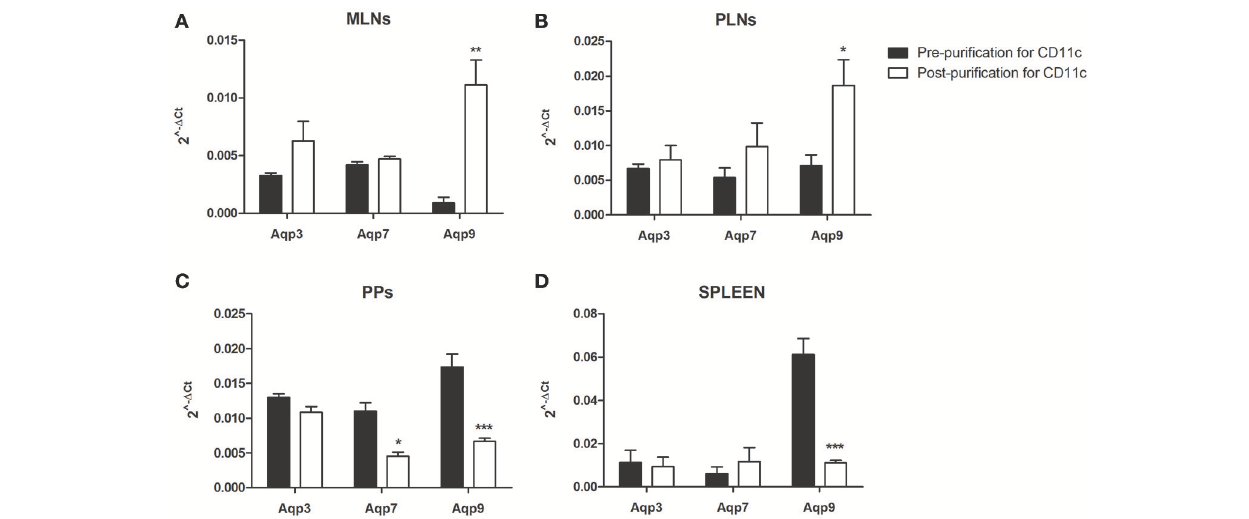
FIGURE 2 | Expression analysis of Aqps in different lymph nodes. The expression of Aqp 3, Aqp 7, and Aqp 9 was assessed in Mesenteric Lymph Nodes (MLNs) (A) , Peripheral Lymph Nodes (PLNs) (B) , Peyer’s Patches (PPs) (C) , and spleen (D) of WT mice. Bars represent the mean ± SEM of 3 independent experiments. * P < 0.05, ** P < 0.01, *** P <